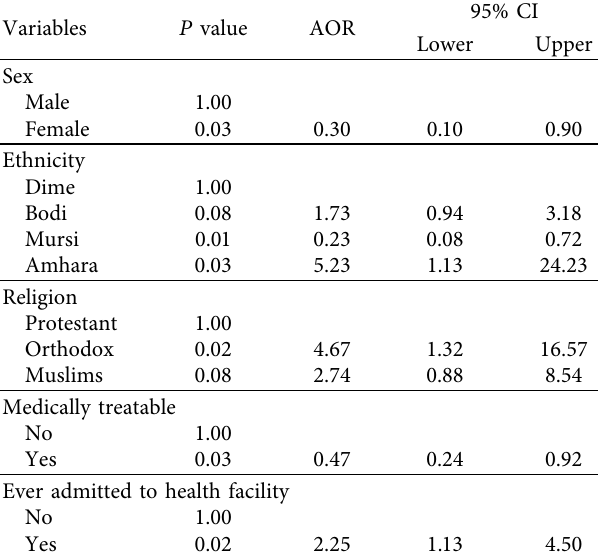
Table 4: Distribution of factors associated with preventive practice related to Onchocerciasis in Selamago in